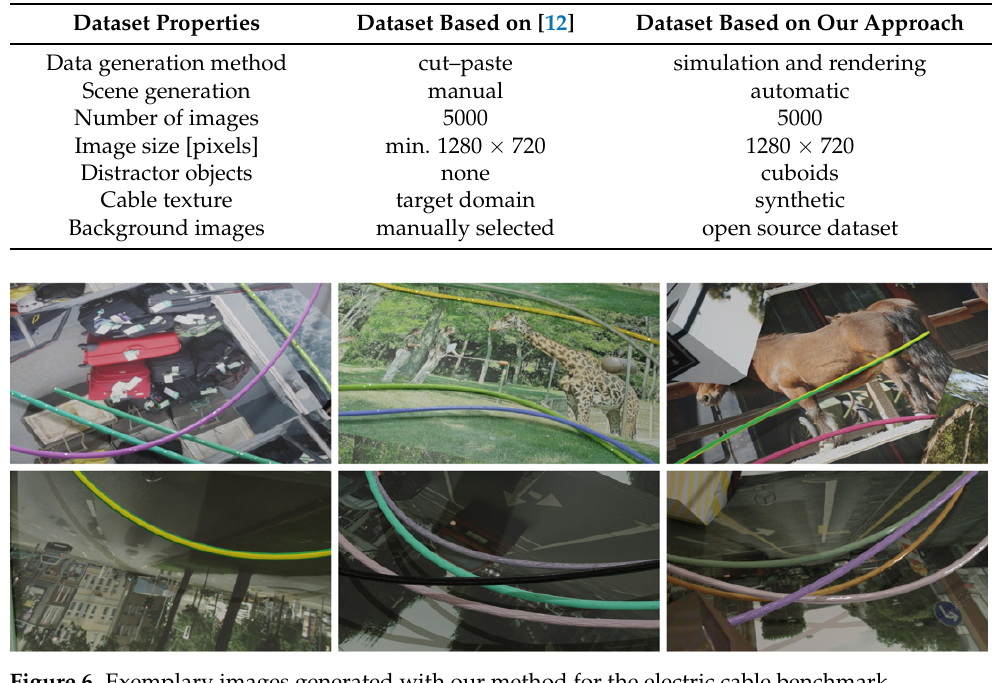
Table 3. Properties of the synthetic training datasets based on [12] and our method.